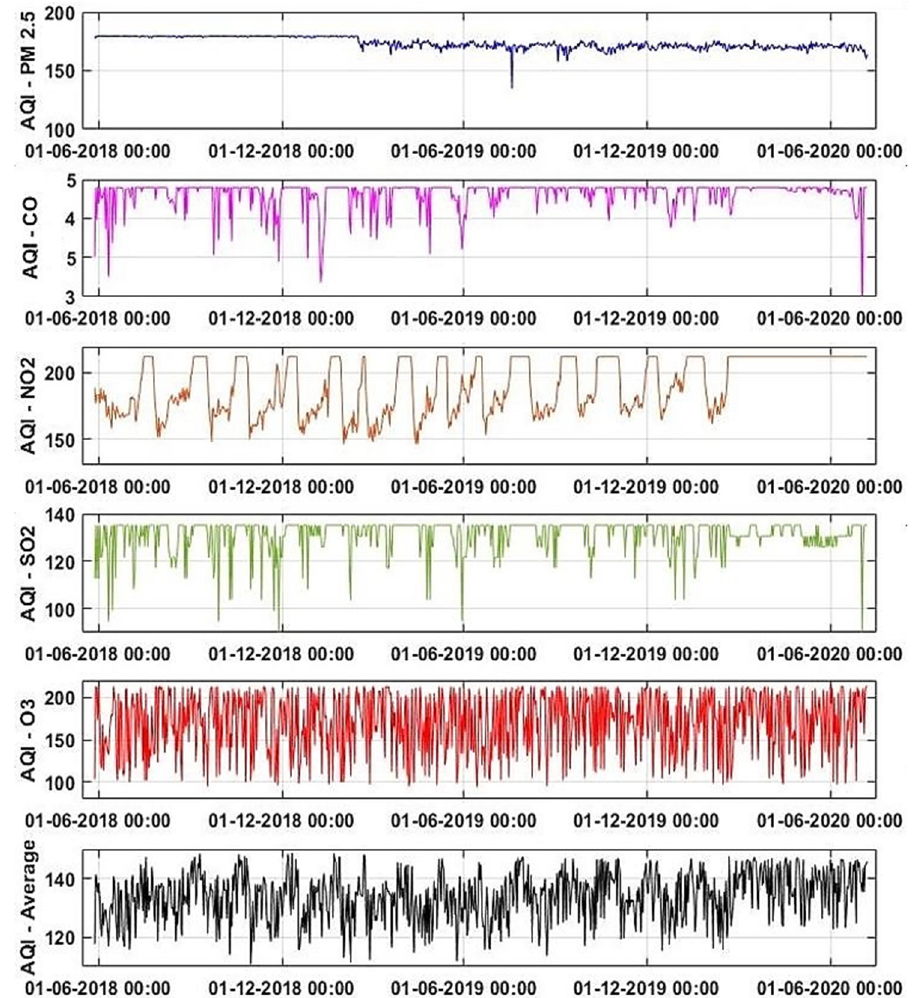
Figure 7. The Cumulative AQI of Four SeReNo V2 nodes using Equations (8)–(12).